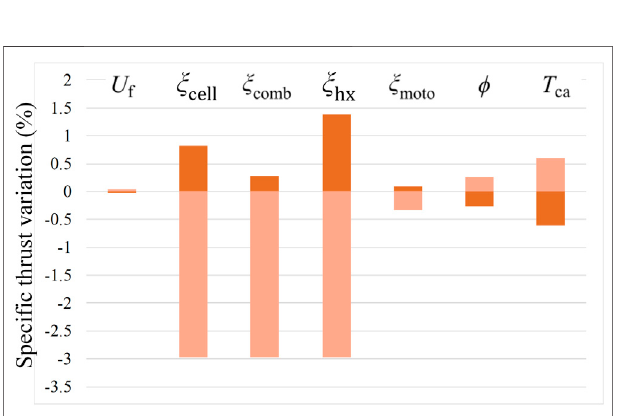
FIGURE9| Spider diagram ofthe sensitivity ofthepower-weightratioof the HEFC engine vs. eight design parameters.